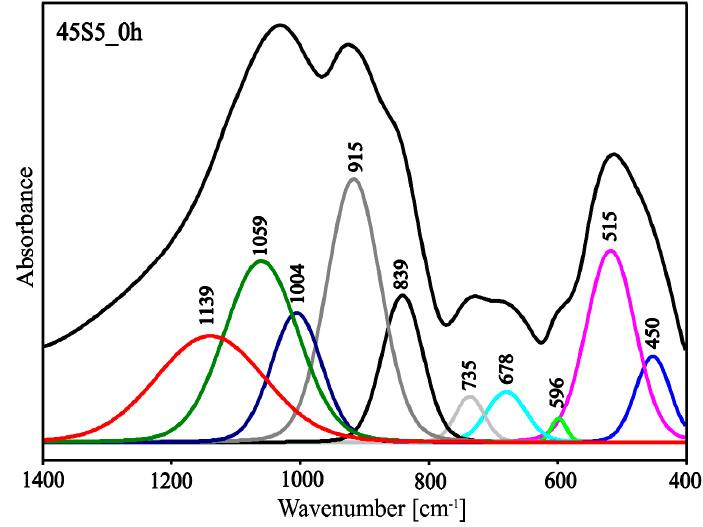
Figure 9. Deconvoluted MIR spectrum of the 45S5_0h sample.